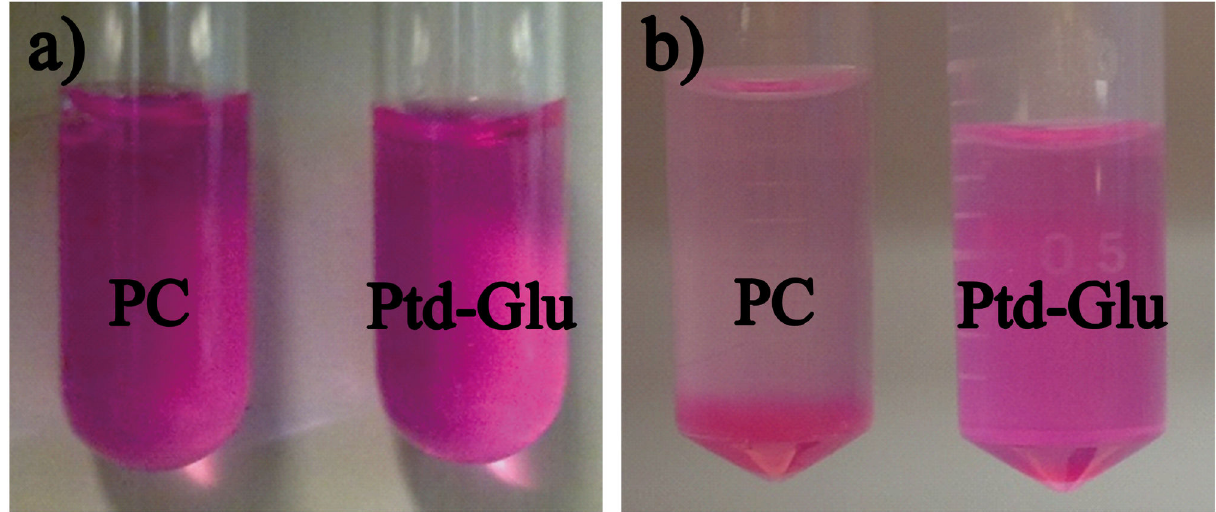
Figure 3. Physical stability of PC and phsphatidyl saccharide nanoliposomes following prolonged storage: a) freshly prepared nanoliposomes, b) nanoliposome after storage for 14 days at room temperature. doi: